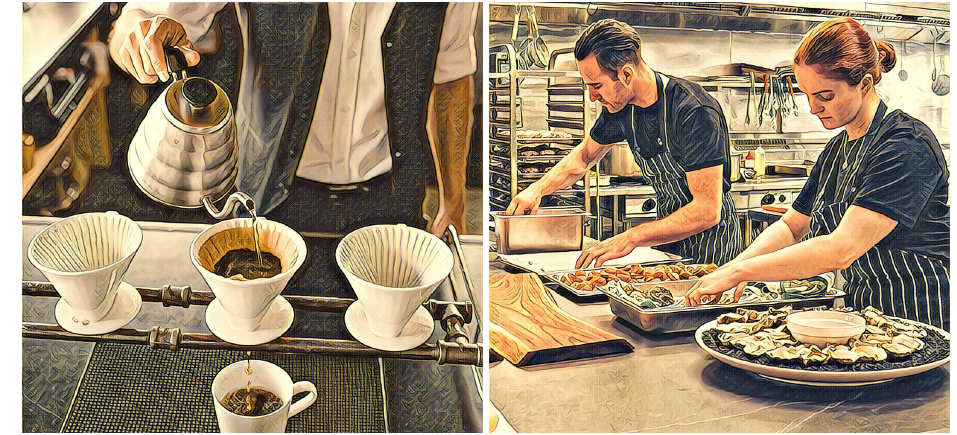
Figure 8. An illustration of SAIT for culinary education and certification